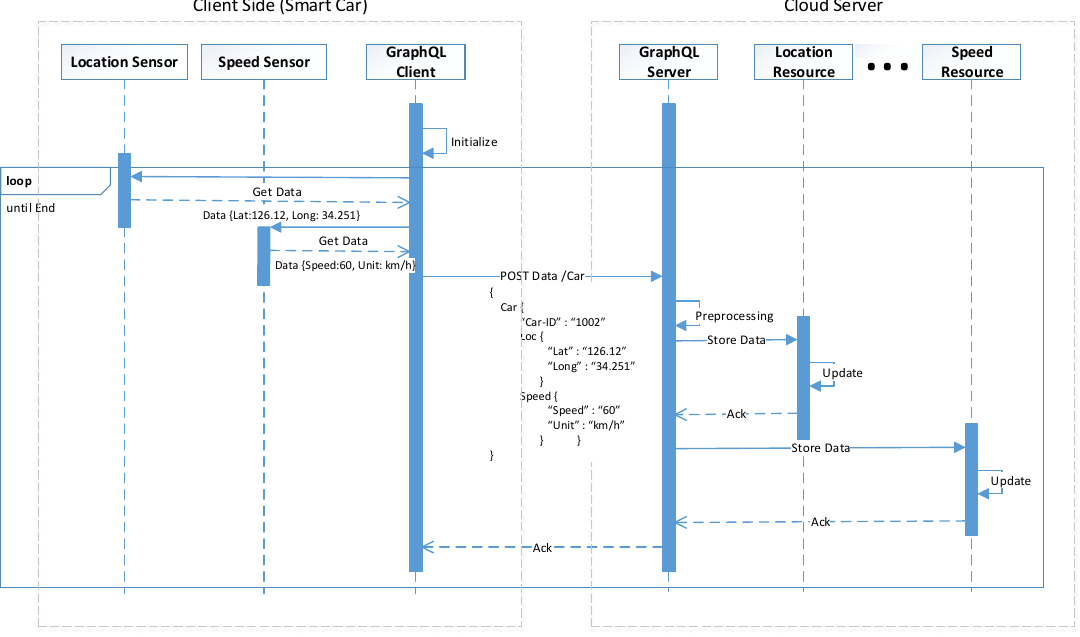
Figure 4. Smart car example scenario with IoT device POSTing data to multiple end-points in single request using GraphQL